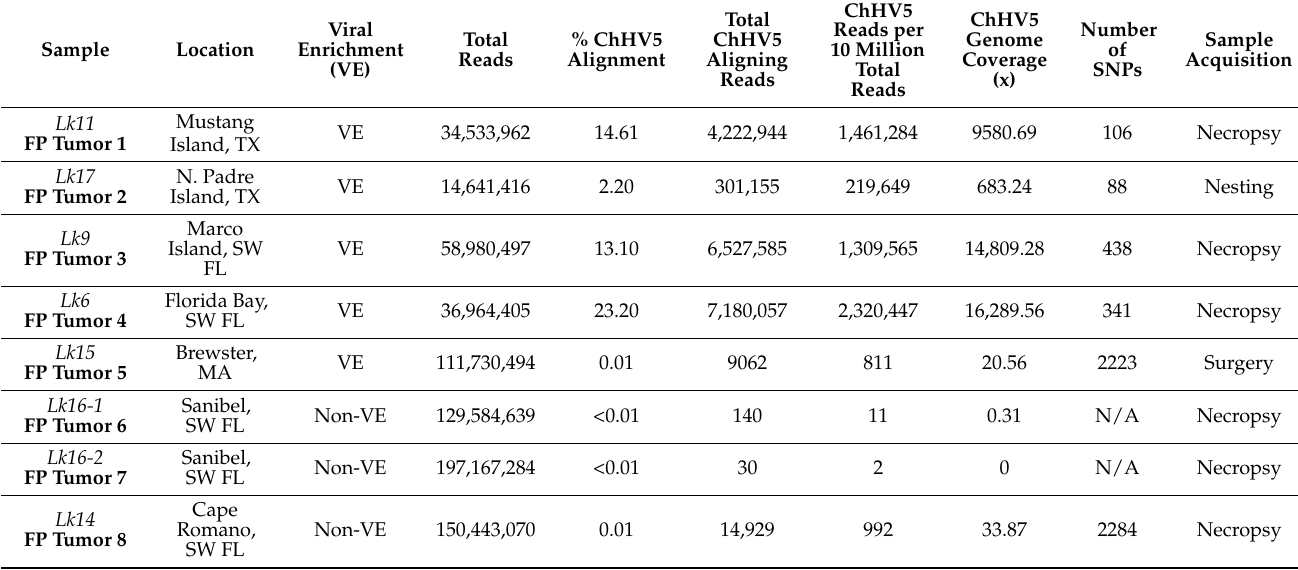
Table 3. Tumor samples from six Kemp’s ridley sea turtles ( Lepidochelys kempii ) with unique ID code, location of turtle used for sampling, viral enrichment status, total reads for each sequenced sample, percentage alignment to the whole ChHV5 genome, total aligning reads to the ChHV5 genome, number of reads aligning to ChHV5 per 10 million total reads, ChHV5 genome coverage, and number of single nucleotide polymorphisms (SNPs). Tumor samples six and seven are from the same individual ( Lk16